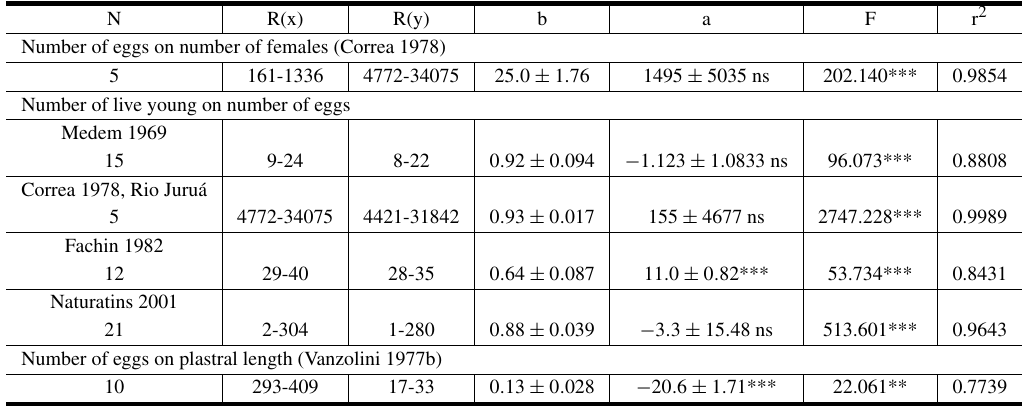
Podocnemis unifilis ,